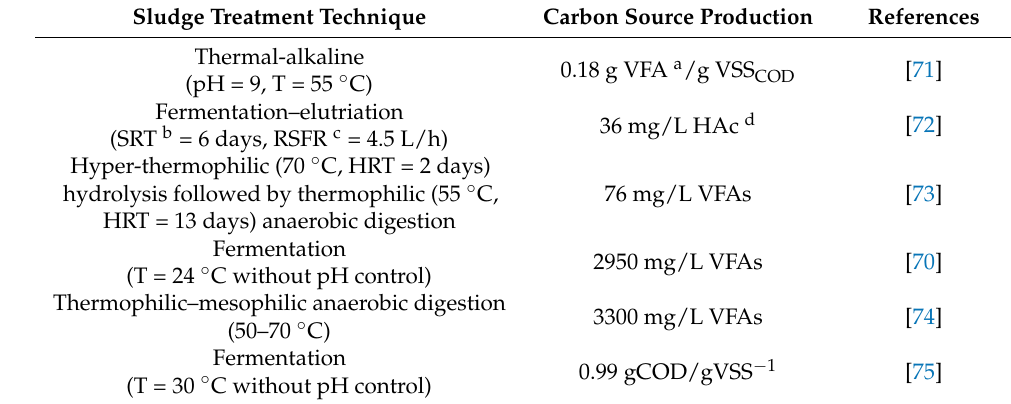
Table 2. Internal carbon source production of primary sludge under different treatment